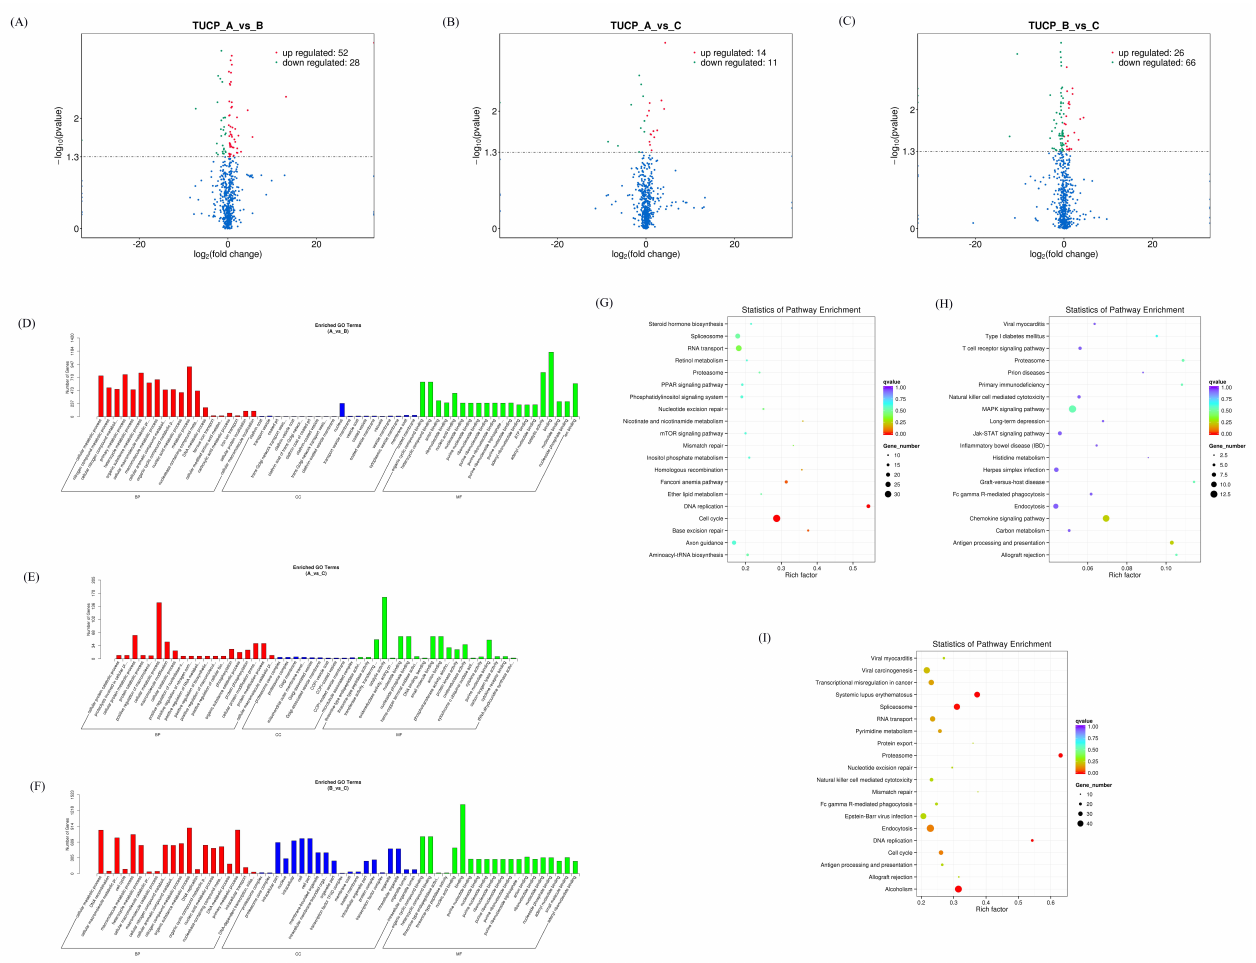
Figure 8. Expression profiles of differentially expressed TUCP. ( A – C ) Volcano plot of differentially expressed cicrRNAs in AvsB group ( A ), AvsC group ( B ), and BvsC group ( C ). ( D – F ) GO analysis for neighbor gene functions of TUCP in AvsB group ( D ), AvsC group ( E ), and BvsC group ( F ). ( G – I ) KEGG annotation for neighbor gene functions of TUCP in AvsB group ( G ), AvsC group ( H ), and BvsC group ( I ). AvsC and AvsB have three intersection TUCPs, and BvsC and AvsC have five intersection TUCPs (Supplementary Materials Table